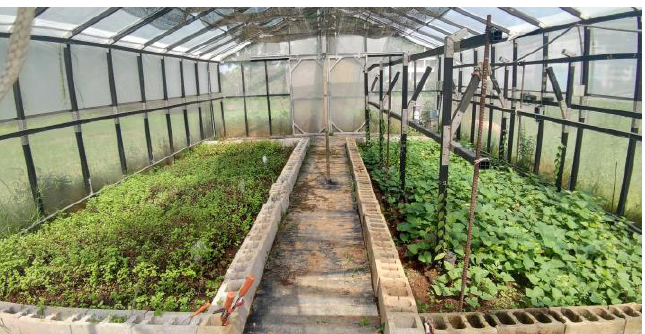
Figure 8. The growing plants in the prototype greenhouse (right garden bed: vanilla, sweet potato; left garden bed: spearmint, apple mint, peppermint, lemon balm).